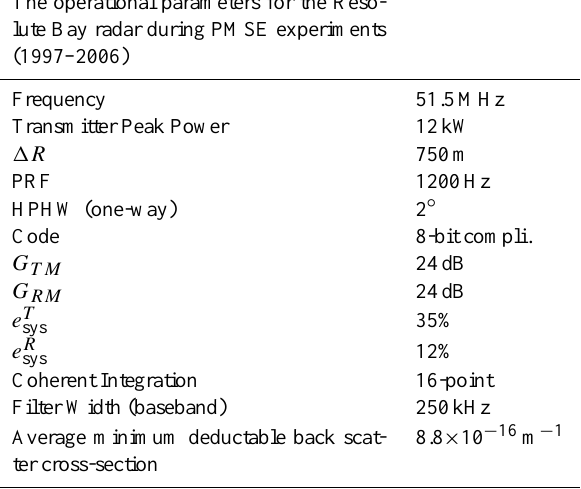
Table 2. Summary of the operational parameters for the Resolute Bay radar, applied during PMSE experiments as well as backscatter cross-section